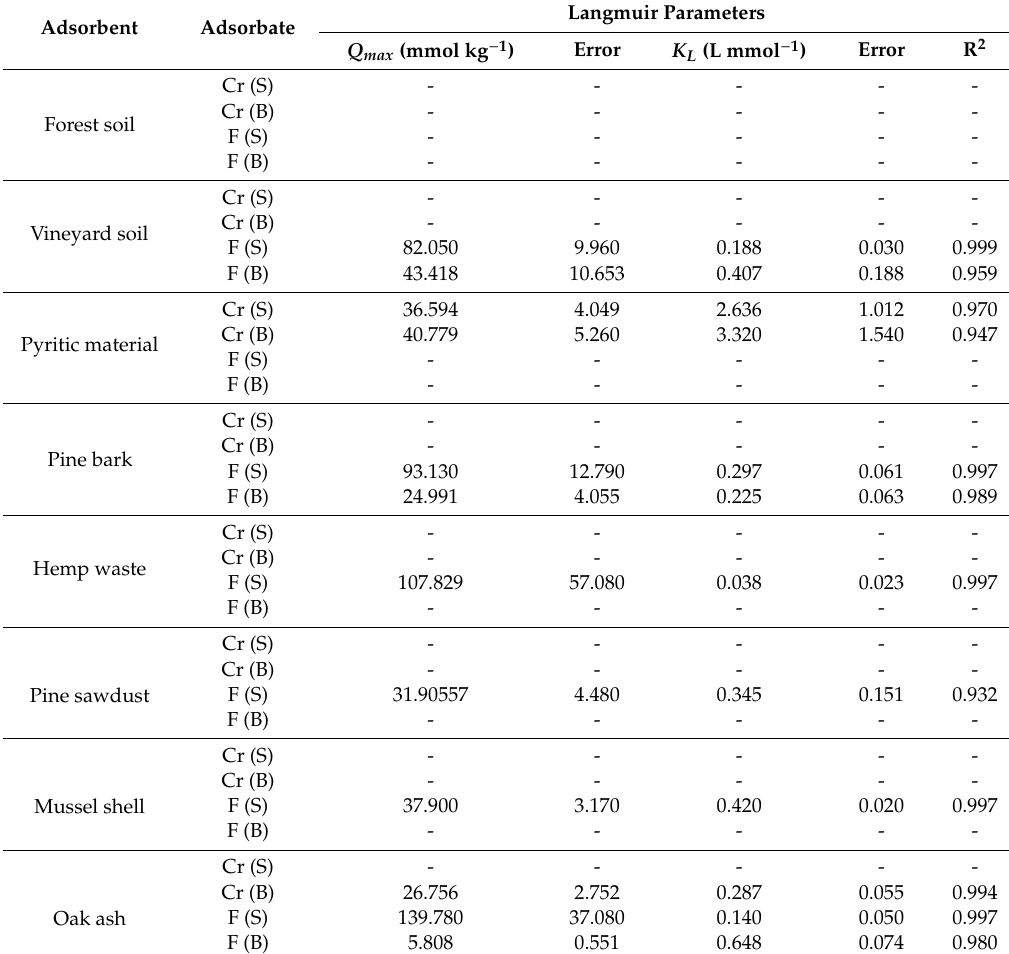
Table 1. Parameters of the Langmuir model for Cr(VI) and F − in individual simple (S) and competitive binary (B)